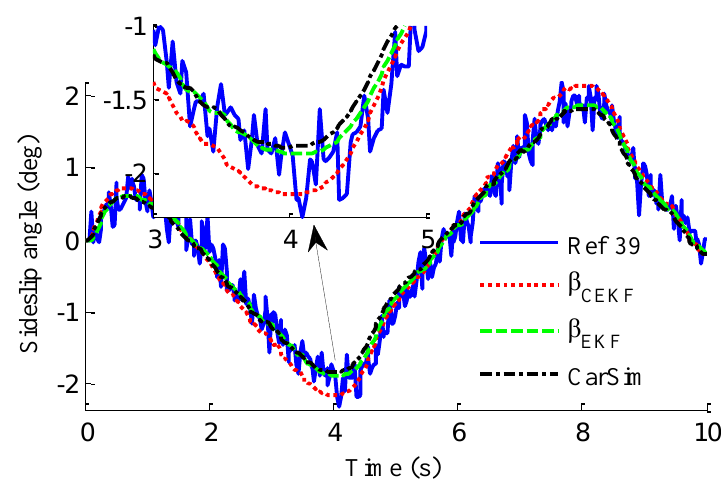
Figure 11. Estimation of sideslip angle.